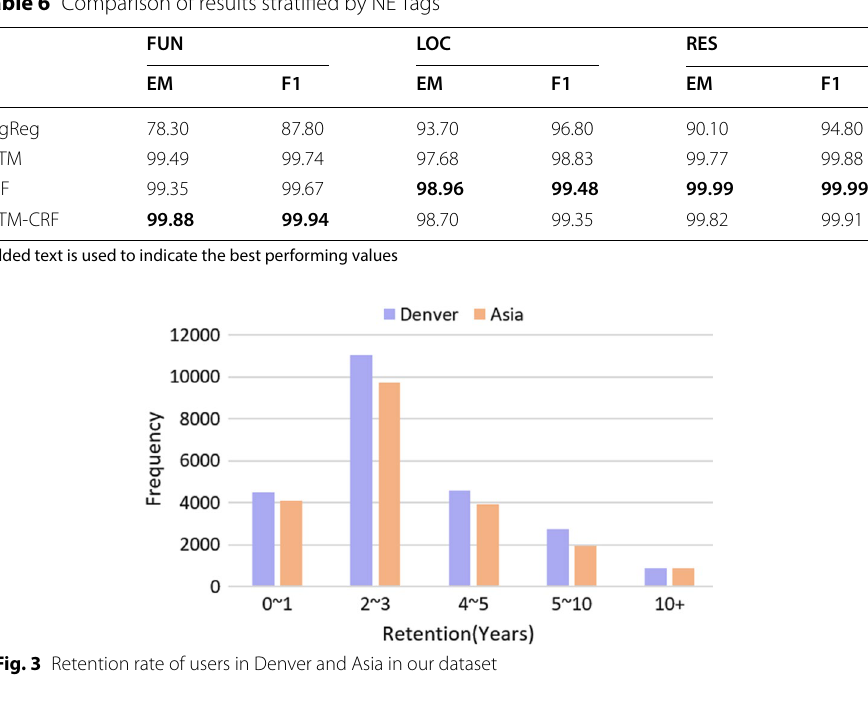
Table 6 Comparison of results stratified by NE Tags FUN